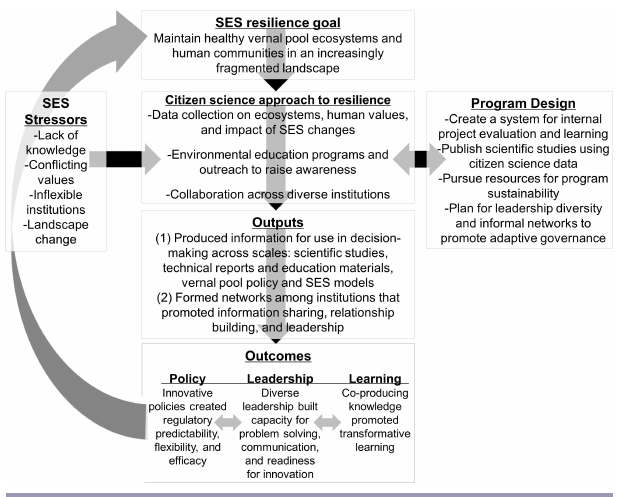
Fig. 2 . The citizen science program design shaped the